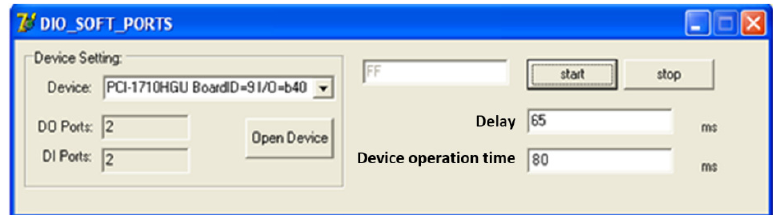
Figure 2. A window of the software controlling the electromagnetic valves.